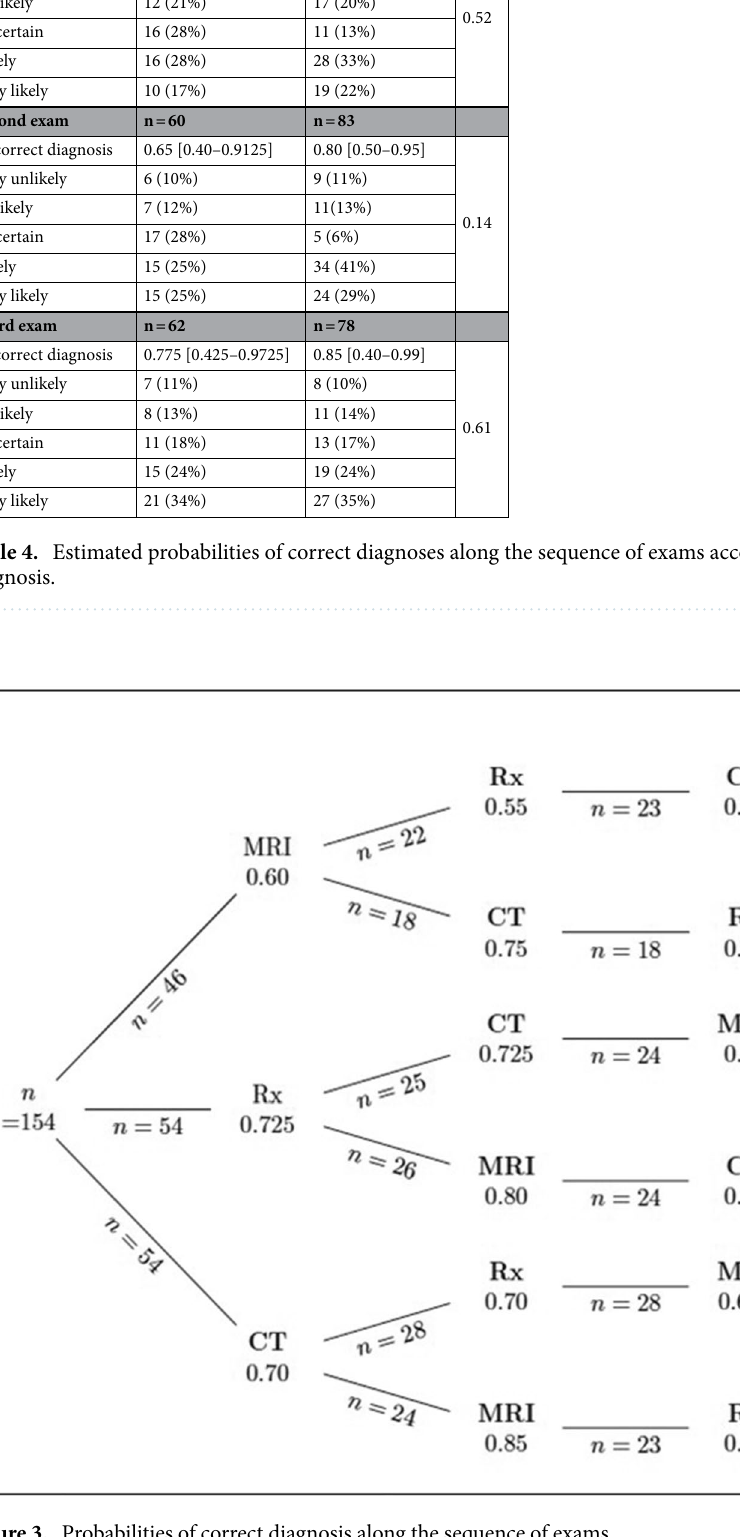
Figure 3. Probabilities of correct diagnosis along the sequence of